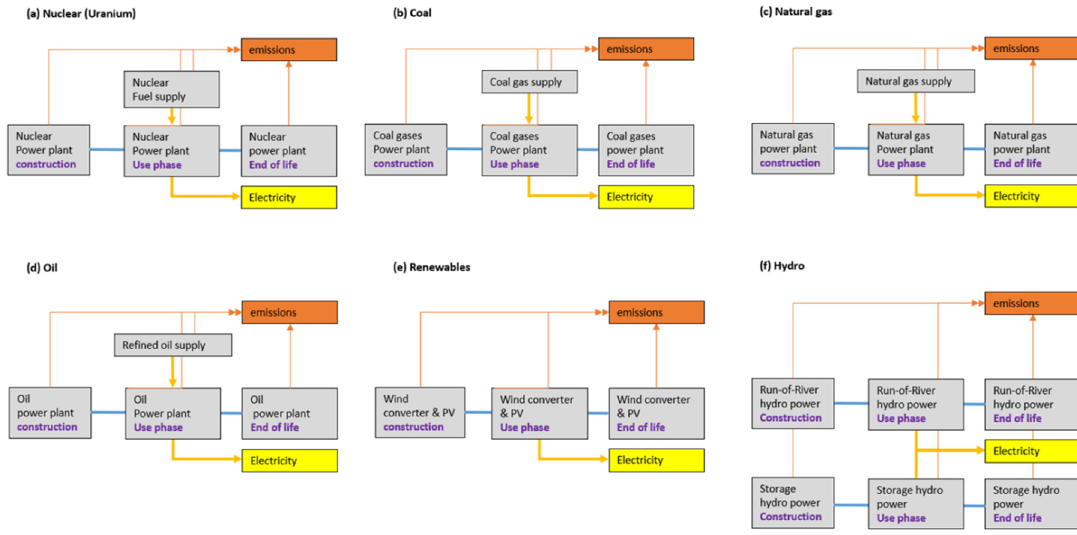
Figure 9. Lifecycle modelling of electricity production with various energy sources (modified from GaBi database 2019); ( a ) Nuclear, ( b ) coal, ( c ) Natural gas, ( d ) Oil, ( e ) Renewables ( f ) Hydro.